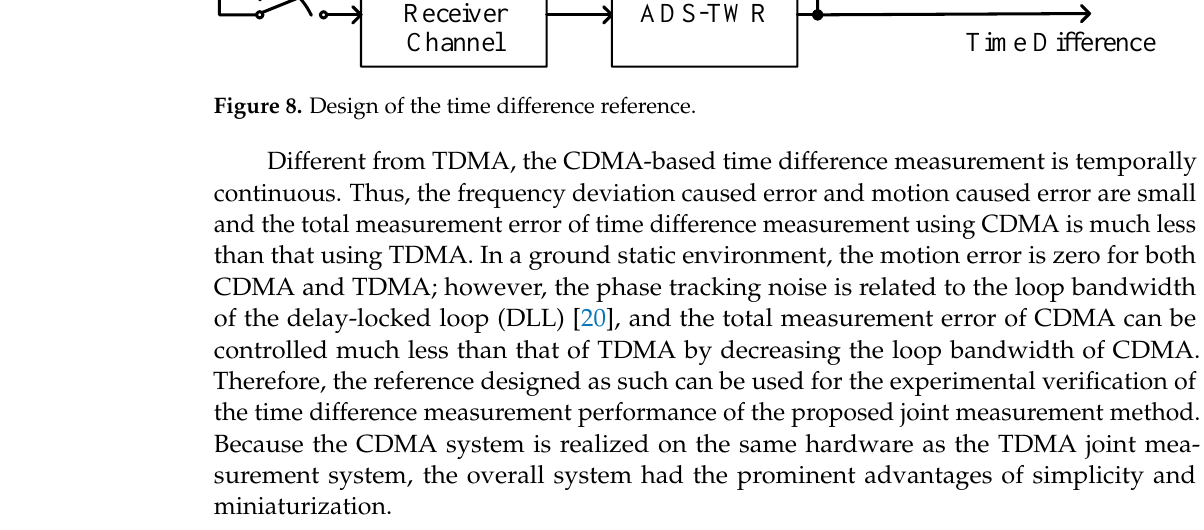
Figure 8. Design of the time difference reference.